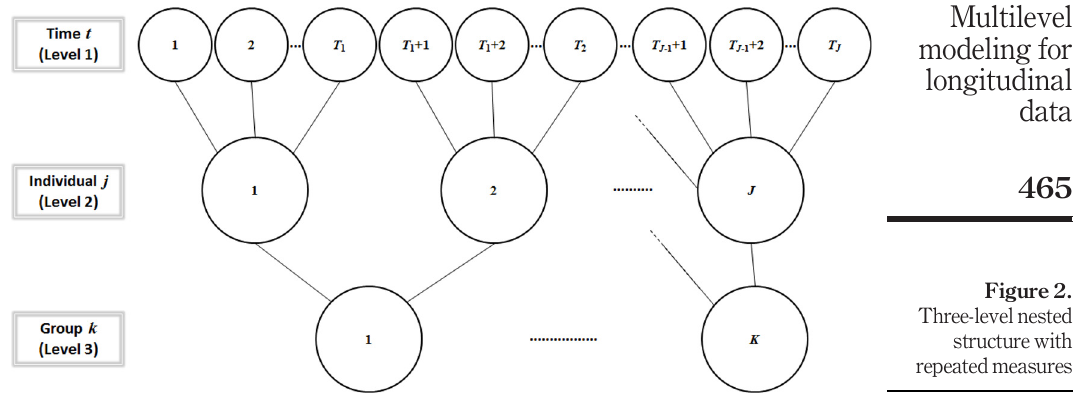
Figure 2. Three-level nested structure with repeated